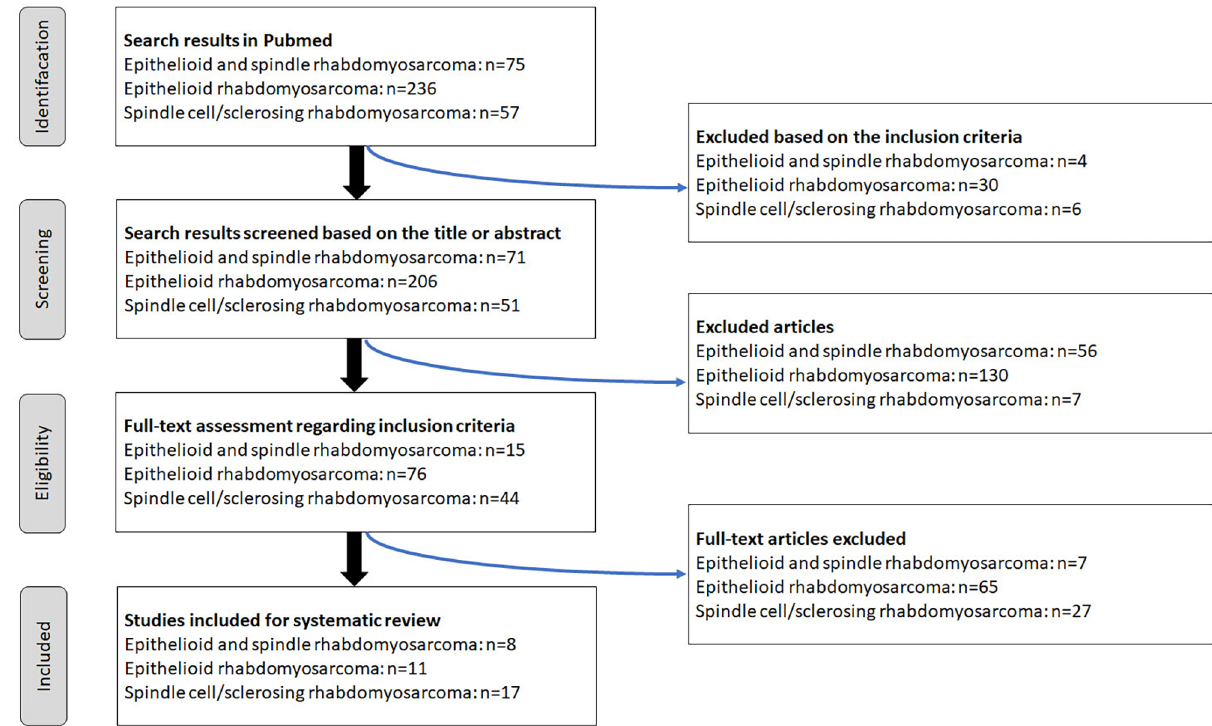
Fig. 4 A PRISMA flowchart of selecting public articles involving ES-RMS, E-RMS and SS-RMS. ES-RMS: epithelioid and spindle rhabdomyosarcoma; E-RMS: epithelioid rhabdomyosarcoma; SS-RMS: spindle cell/sclerosing